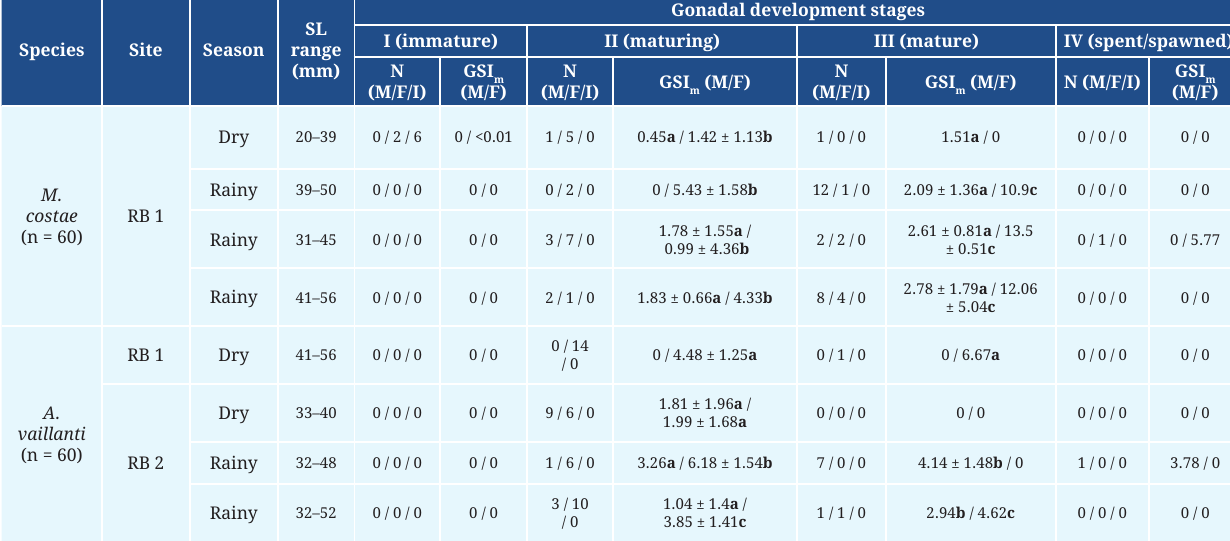
TABLE 3 | Abundance and mean values of the gonadosomatic index (GSI ) by gonadal stages obtained for Moenkhausia costae (RB 1) and Anchoviella m vaillanti (RB 1 and RB 2). RB = Paraíba do Norte River basin; SL = standard length; N = abundance; M = males; F = females; I = indeterminate. Different bold letters (a, b, c) in the columns indicate statistical differences (ANOVA; p<0.05) between gonadal stages of each sample.